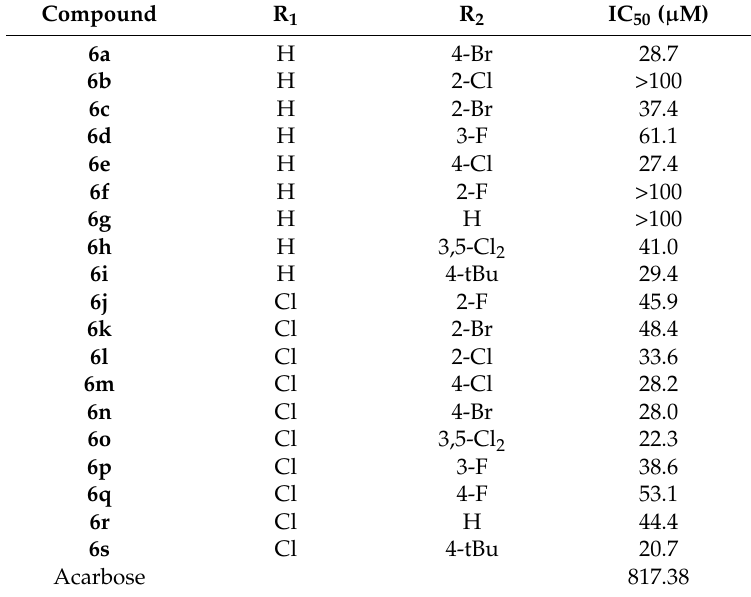
Table 1. α -Glucosidase inhibitory activity of novel benzothiazole-triazole derivatives ( 6a – 6s ). Compound